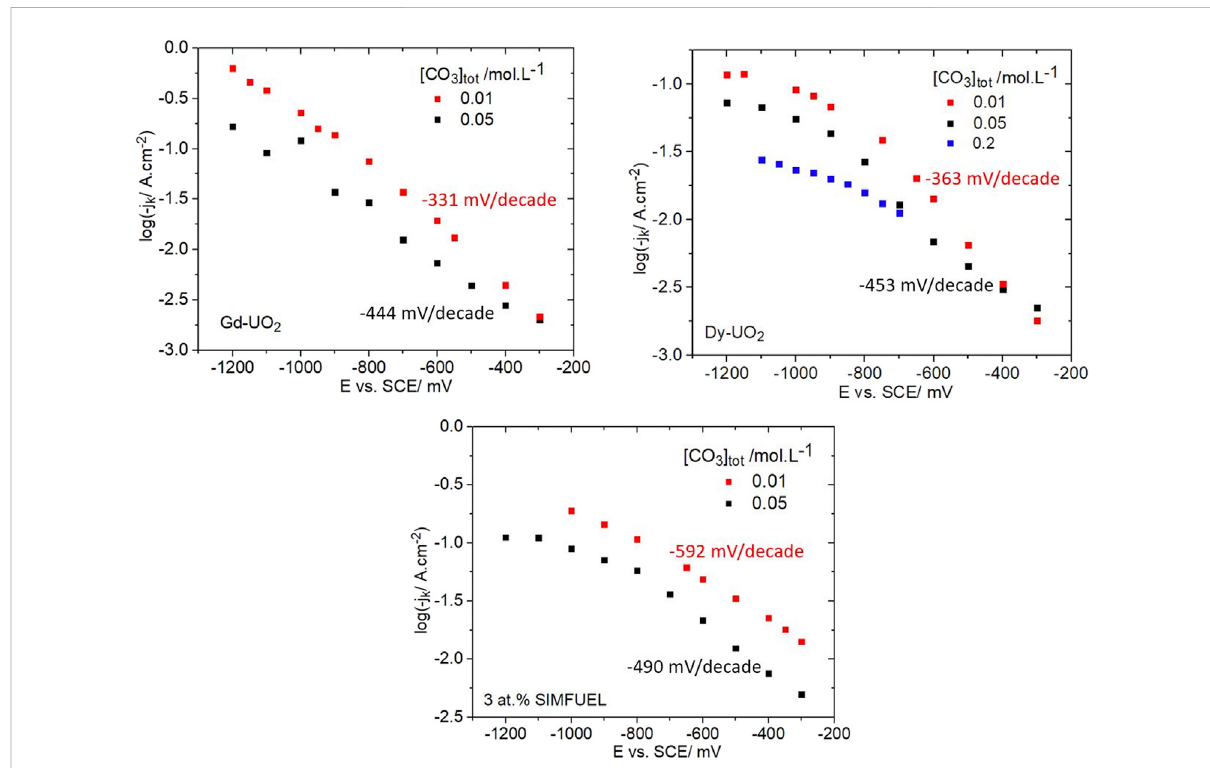
The formation of a U V surface state is also the fi rst step in the anodic oxidation/dissolution of UO 2 , a reaction also involving the incorporation of O II into interstitial oxygen vacancy (O V ) sites in the UO 2 matrix to produce a thin U 1 – 2x IV U 2x V O 2+x surface layer (Goldik et al., 2004).